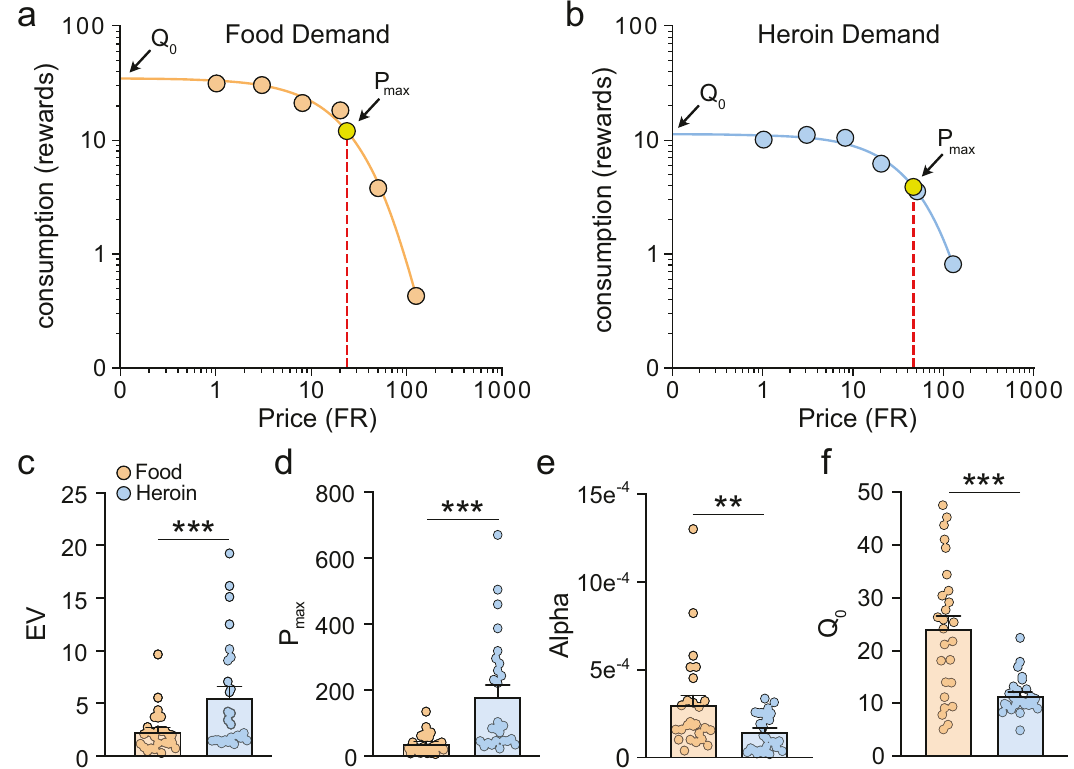
Fig. 2 Heroin is valued more highly than food, assessed using behavioral economics principles. Representative demand curves for food ( a ) and heroin ( b ) demonstrate more inelastic demand for heroin compared to food in rats. c The essential value (EV) and d maximum price rats were willing to pay to defend desired consumption ( P max ) were higher for heroin than for food. e Demand elasticity ( α ) and f consumption at null cost ( Q 0 ) were higher for food than for heroin. ** p < 0.01, *** p < 0.001 comparing food versus heroin (2-tailed paired t test). Data are shown as mean ± SEM ( c – f with donkey anti-mouse Alexa fl uor ® 594 (1:500; Jackson ImmunoResearch Labs Cat# 715-585-151, RRID:AB_2340855) secondary antibody. Sections were mounted onto slides and coverslipped with ProLong Diamond Antifade mounting medium with DAPI (Invitrogen Cat# P36971). Images were acquired with a slide scanner microscope (Olympus VS120; 10x air objective) and imported into Imaris software (Imaris, RRID:SCR_007370). Oxytocin neurons were counted semi-automatically using the Imaris spot detection function. The number of oxytocin cells in the PVN was counted in both hemispheres and averaged across two sections per animal. For orexin counts, images were acquired using a Zeiss Axio Zoom V16 microscope. Tiled photographs were compiled at ×20 magni fi cation using Zen 2 imaging software (Carl Zeiss Microscopy). As in our previous studies [60, 64], the number of orexin cells was counted separately in the LH versus the dorsomedial hypothalamus (DMH) and perifornical area (PF) orexin cell fi elds across both hemispheres using the manual quanti fi cation function- ality of Zen 2 software, and averaged across three sections per animal. Orexin sub fi elds were delineated as described previously [60, 64] by drawing a line 100 microns lateral to the fornix, with the fi eld medial to this line representing PF/DMH and lateral to this line representing the LH orexin fi eld. Counts of oxytocin and orexin cells were conducted by separate investigators blind to the experimental condition of the animals.